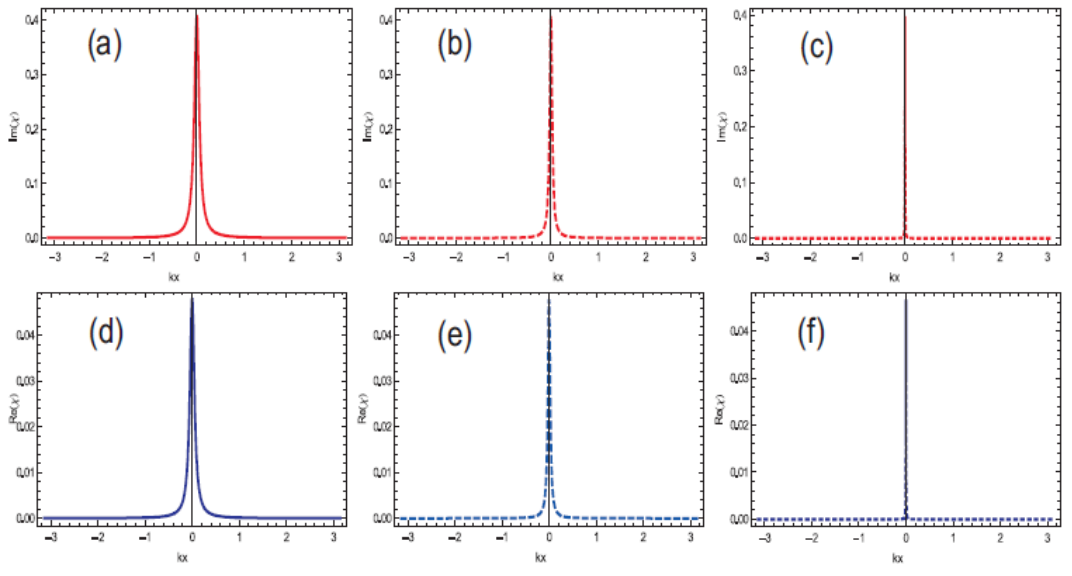
Figure 6. Localization of atom vs kx at the parameters γ = 1 GHz , | Ω 1,2,3 | = R = 50 γ [ a , d ] ,100 γ [ b , e ] ,1000 γ [ c , f ] , γ 1,2 = 1 γ , γ 3 = 0 γ , η 1,3 = 0.5, η 2 = − 0.5, ϕ =